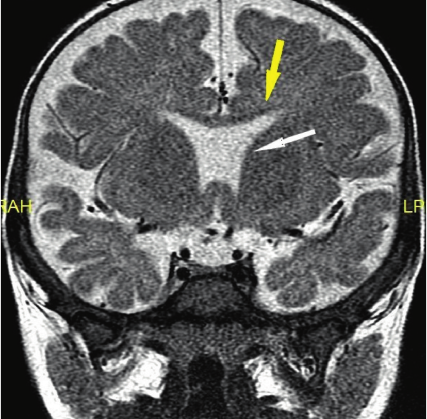
Figure 1: Absence of the septum pellucidum (white arrow) and pointing of frontal horns (yellow arrow) seen on MRI of the